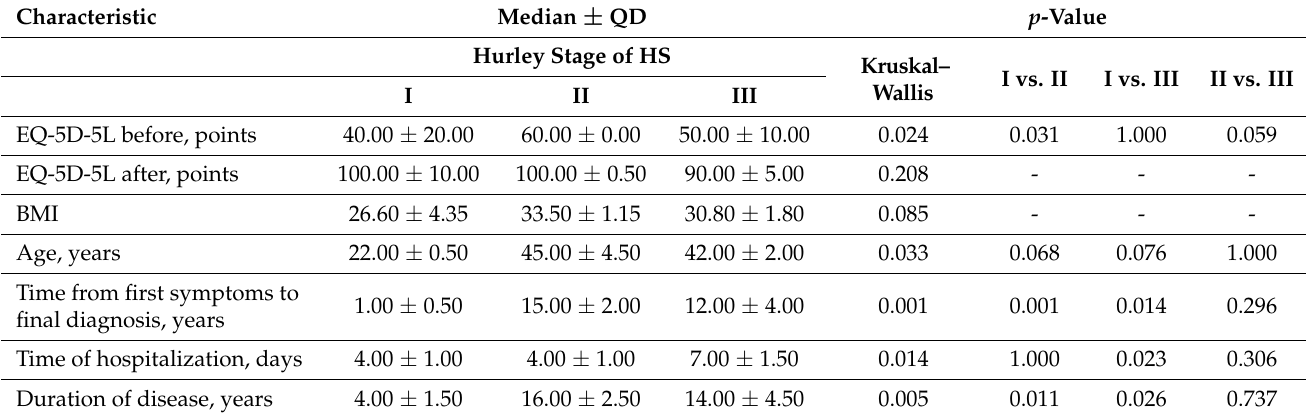
Table 2. Clinical characteristics of HS patients in regard to the Hurley stage of Hidradenitis suppurativa.